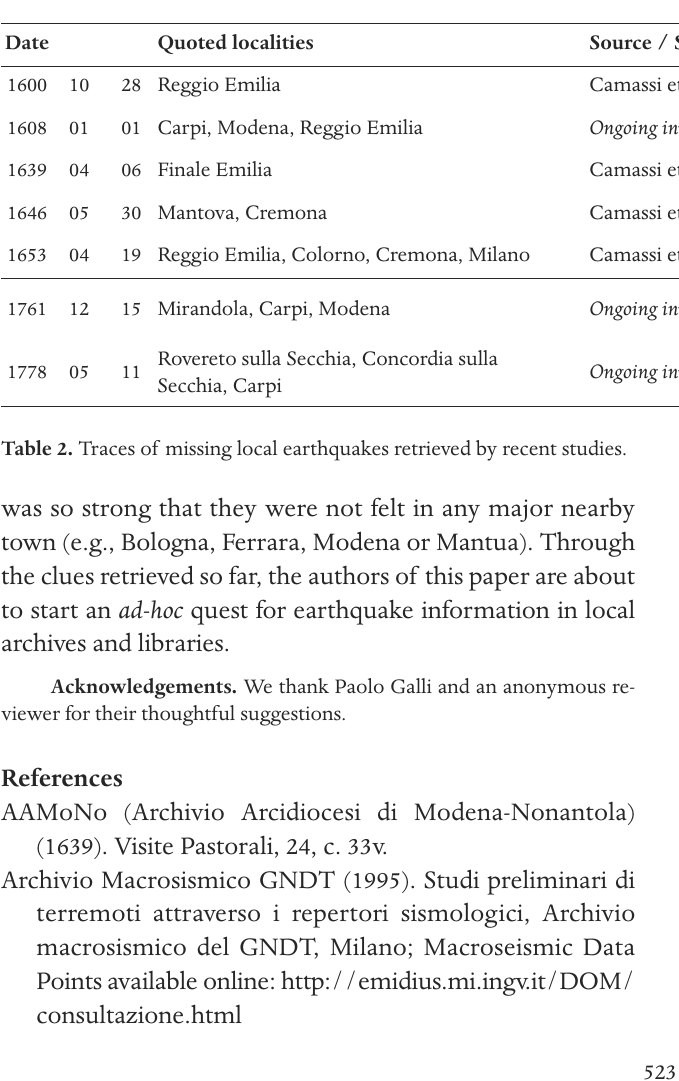
Figure 3. Locations where evidence of some missing earthquakes has been